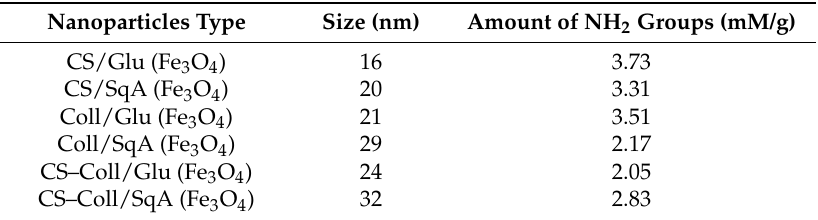
Figure 2. Scheme of collagen and chitosan crosslinking with squaric acid (SqA). Table 1. Characteristic of prepared nanoparticles surface 1 .